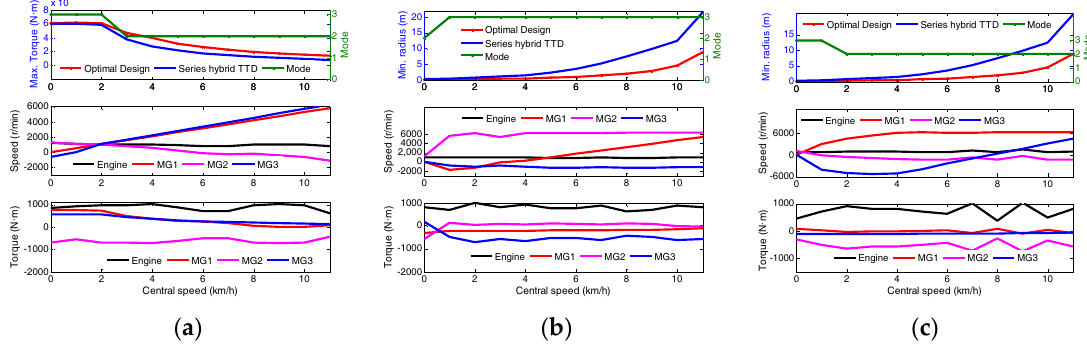
Figure 16. Performance of the final optimal design: ( a ) straight driving, ( b ) left turning, ( c ) right turning.